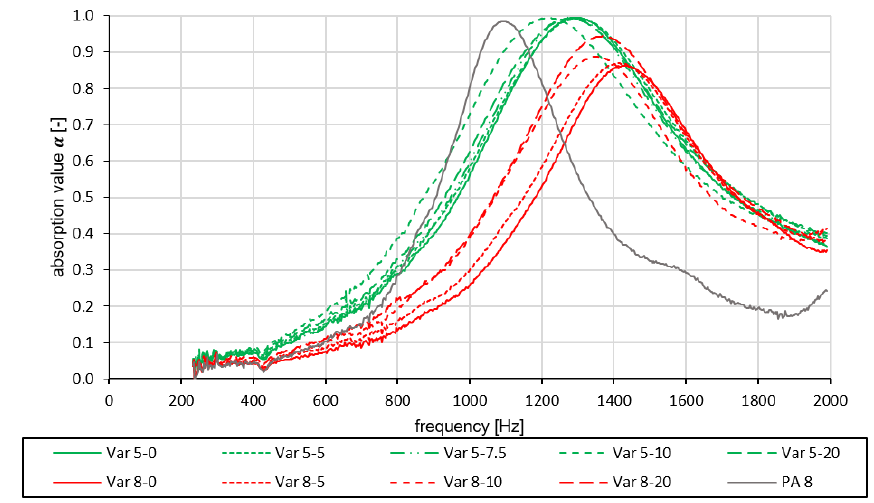
Figure 7. Absorption curves of all tested variants including a reference variant (PA